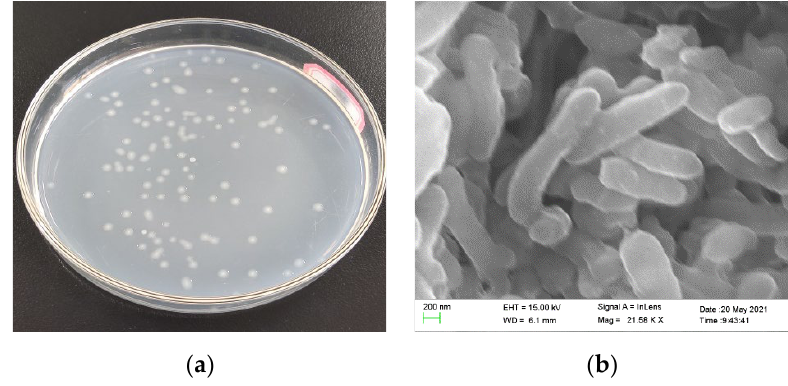
Figure 1. ( a ) Colony morphology; ( b ) SEM image of strain LY1024. Table 1. Sequence comparative analysis between strain LY1024 and other bacteria. Description (16S Ribosomal RNA Gene Partial Sequence)